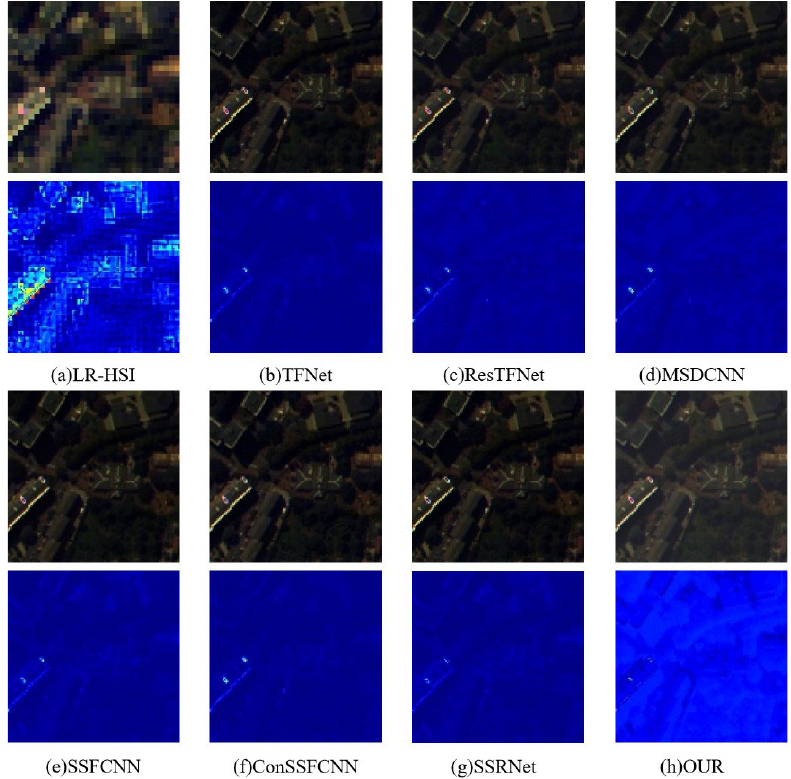
Figure 9. Sharpening results on the Pavia dataset. The first row is the fusion result, and the second row is an image obtained by pseudo-coloring the differences between the fusion result of the first row and the ground truth RGB image. All images are displayed in true color (red, green, and blue being the three